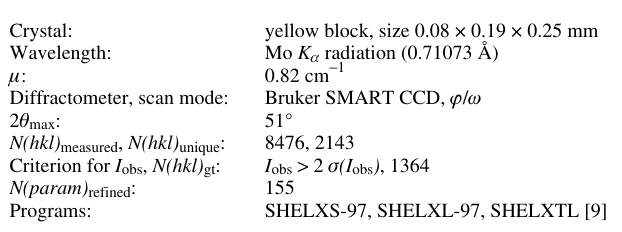
Table 1. Data collection and handling.